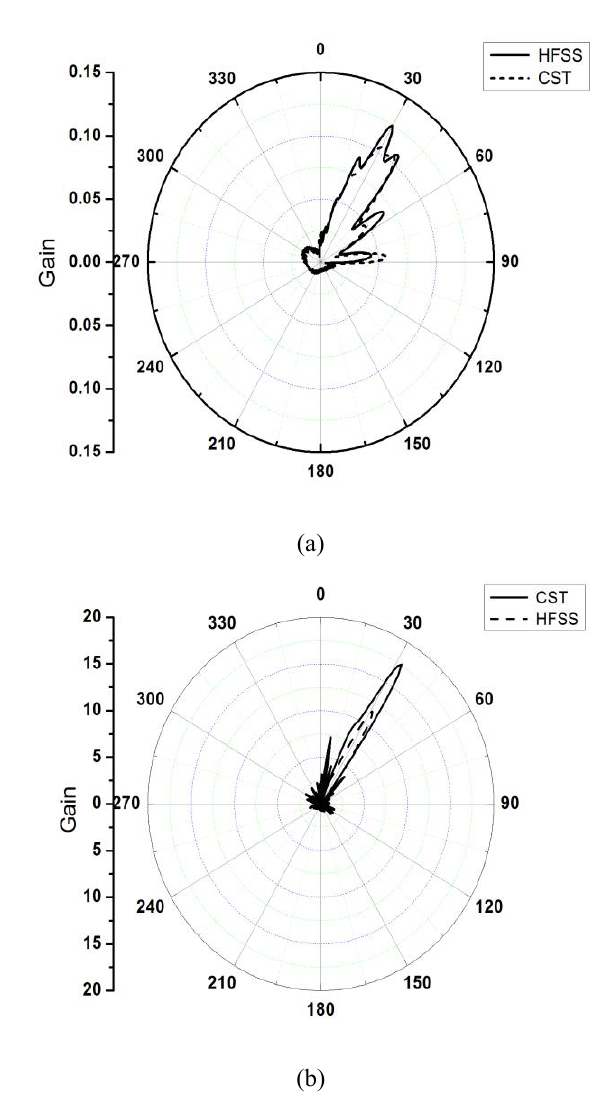
Figure 9: Gain (ratio) along E-plane at 𝑓 0 = 300 𝐺𝐻𝑧 , (a) for doped silicon, and (b) for a thin gold